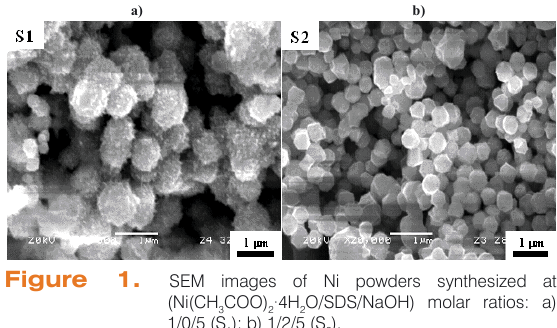
Figure 1. SEM images of Ni powders synthesized at